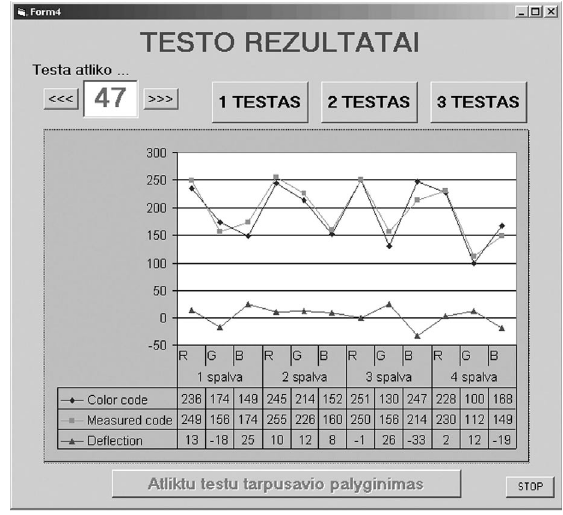
Fig 8. A window displaying test